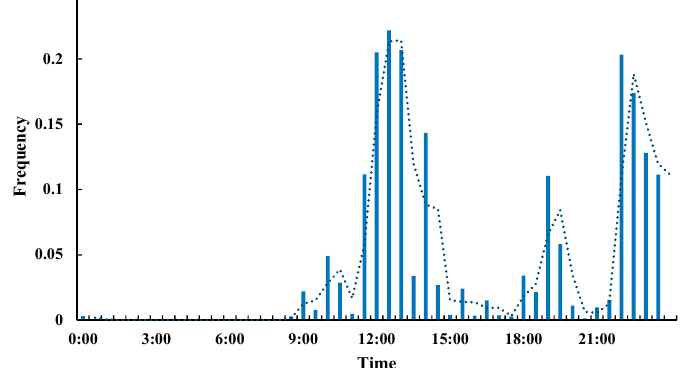
Figure 3. Initial charging time sample distribution of buses.